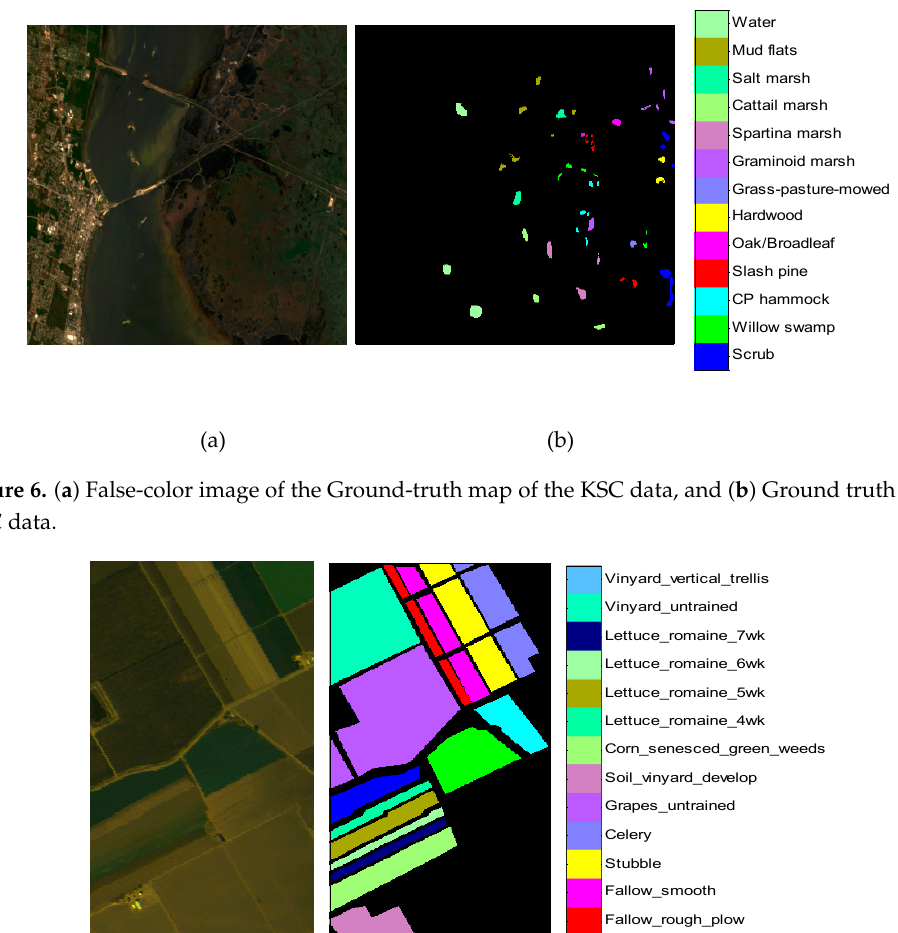
Figure 5. (a) False-color image of the Pavia University data, and (b) Ground truth of the Pavia University data.